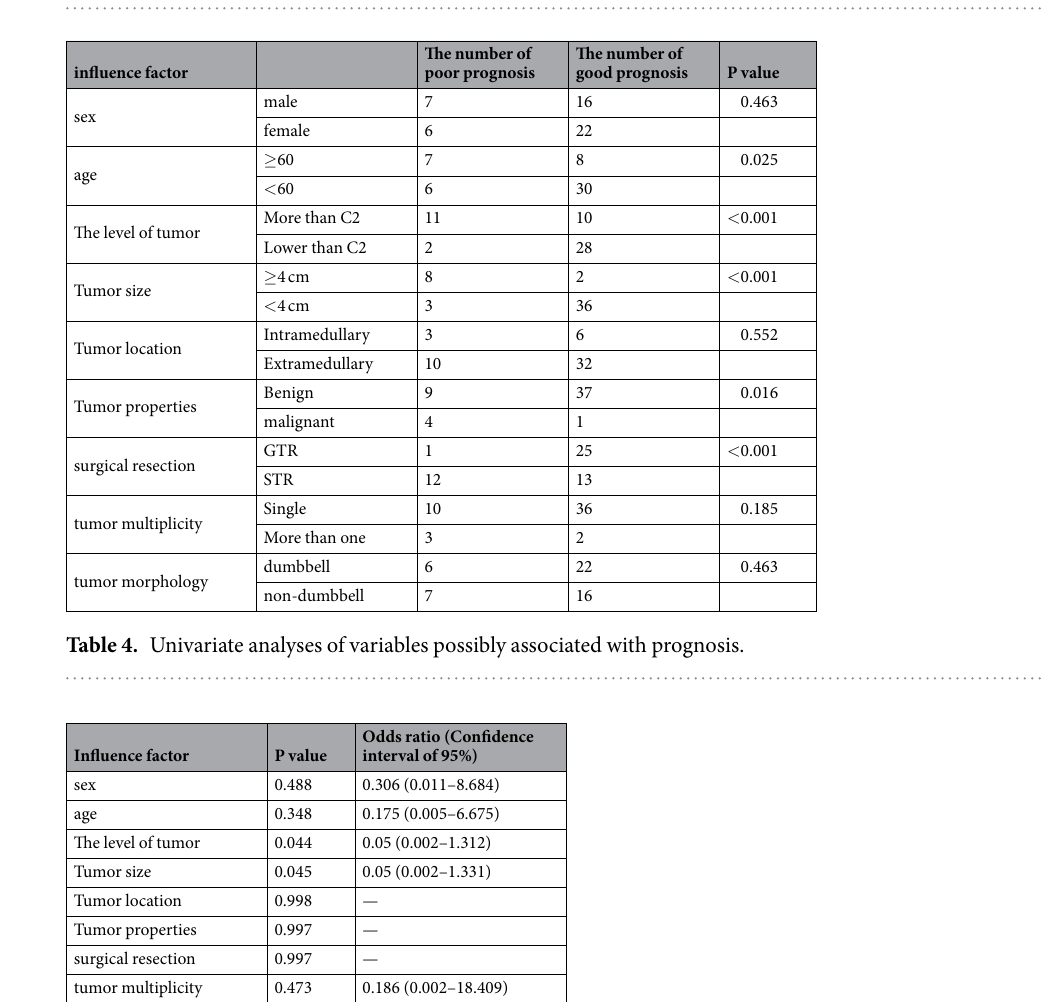
Table 3. Neurological function at the preoperative and the fifth year according to the McCormick functional schema.